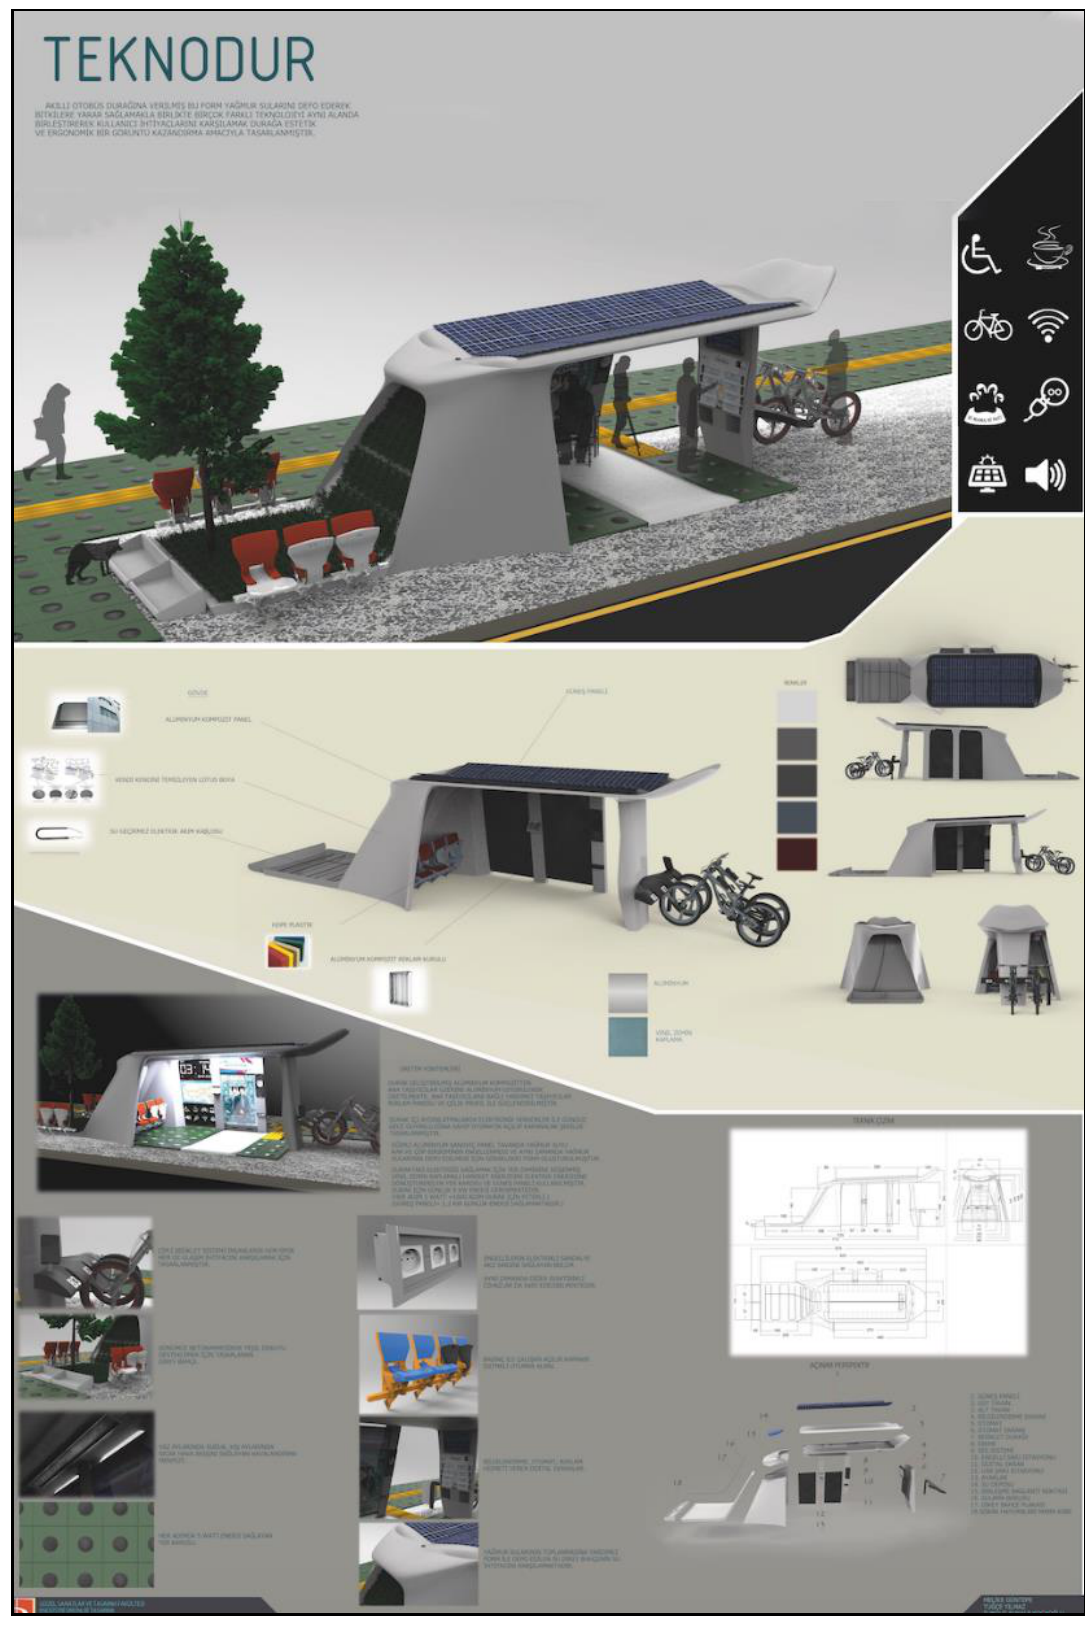
Figure 9. Presentation sheet of the completed